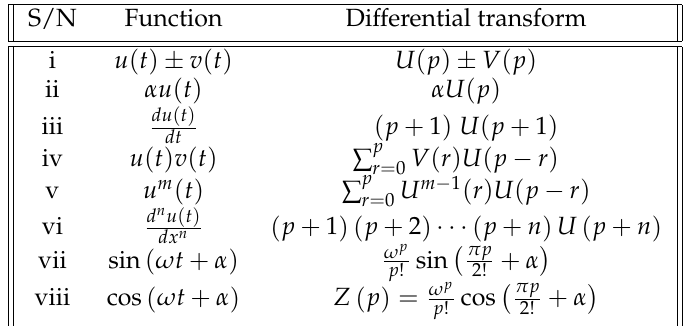
Table 2. Operational properties of differential transformation